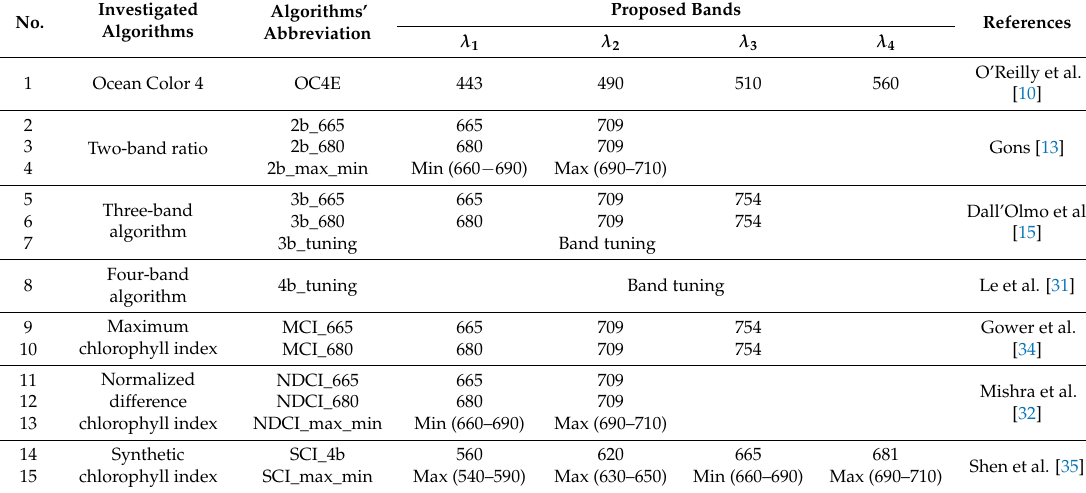
Table 3. Investigated algorithms with the proposed bands for each algorithm